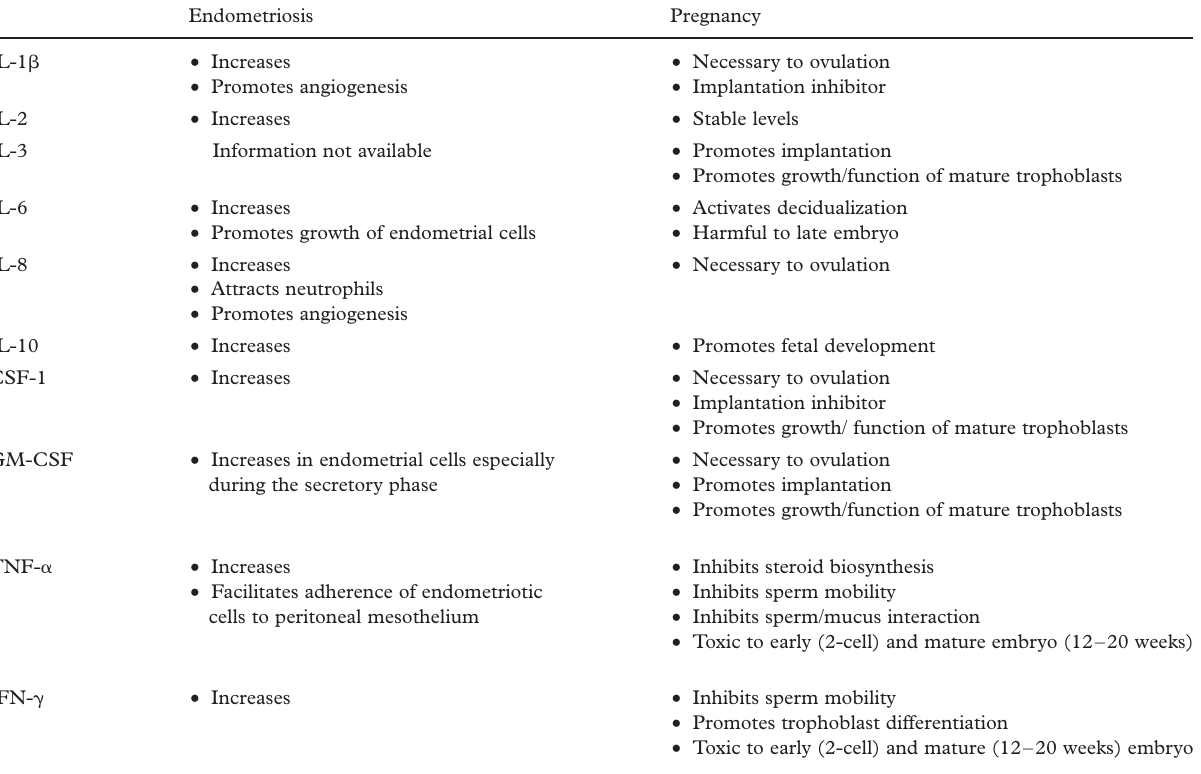
Table II. Comparative effect of cytokines in endometriosis and